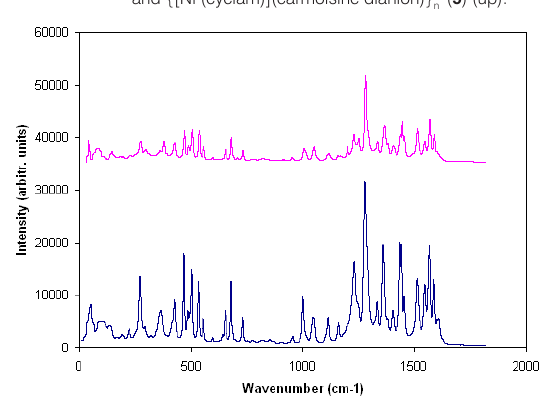
{[Cu II (cyclam)](carmoisine dianion) (H and {[Ni II (cyclam)](carmoisine dianion)}